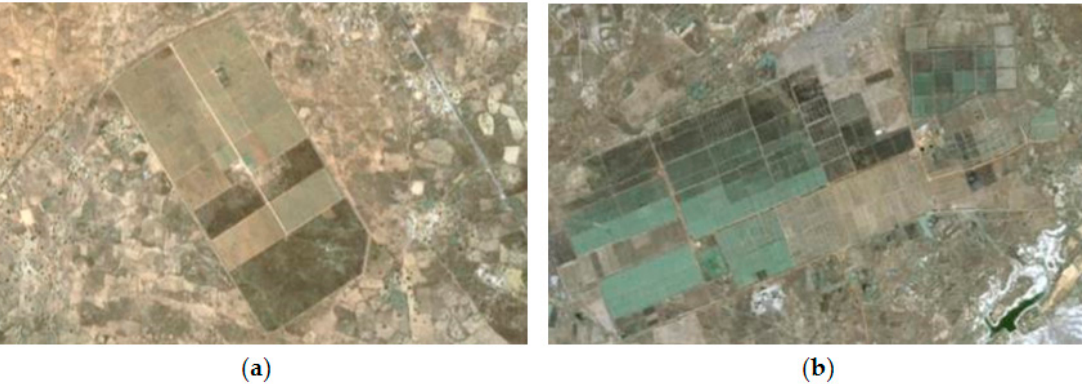
Figure 1. Illustration of spatial footprints for agro-industrial